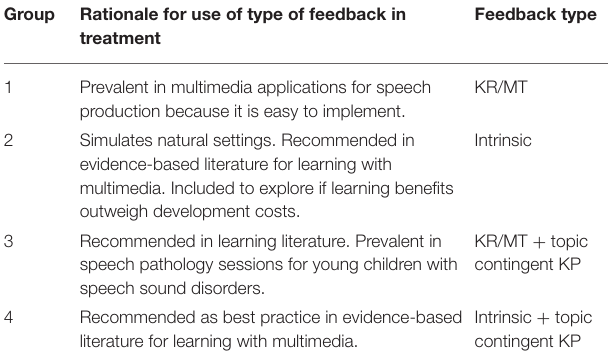
TABLE 3 | Rationale for feedback type in experimental conditions. Group Rationale for use of type of feedback in